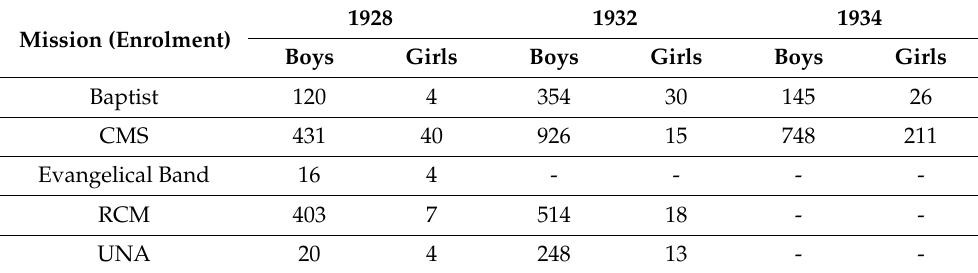
Table 1. No of registered pupils in christian mission schools showing low enrolment of girls. Mission (Enrolment)